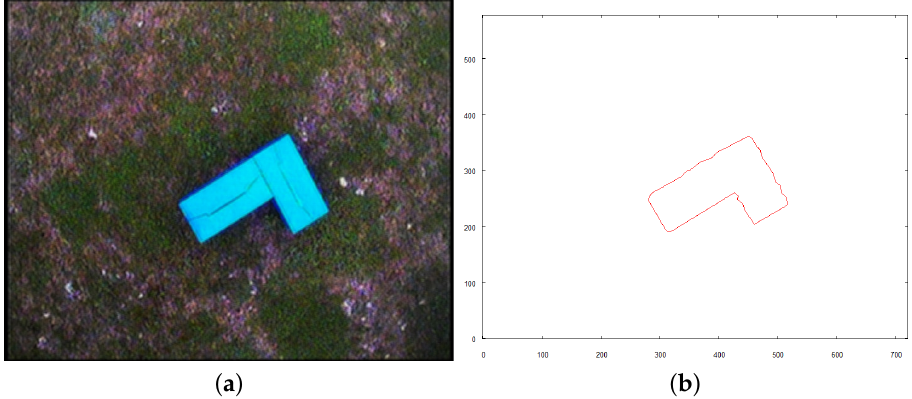
Figure 23. Intermediate steps to obtain vector representation of object A . ( a ) preprocessed image; ( b ) vector representation of object.